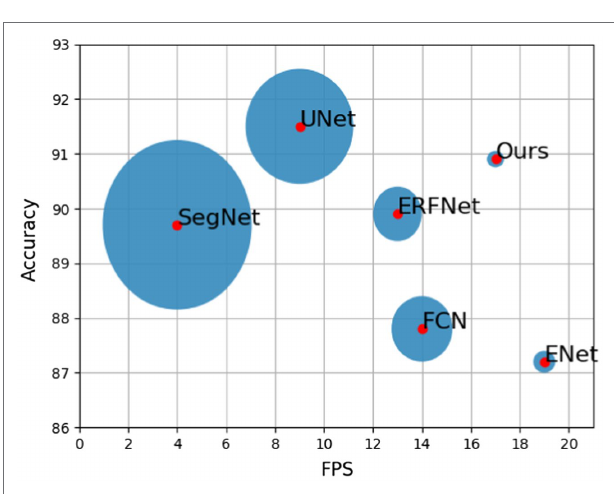
FIGURE 9 | Performance comparison of various algorithms.